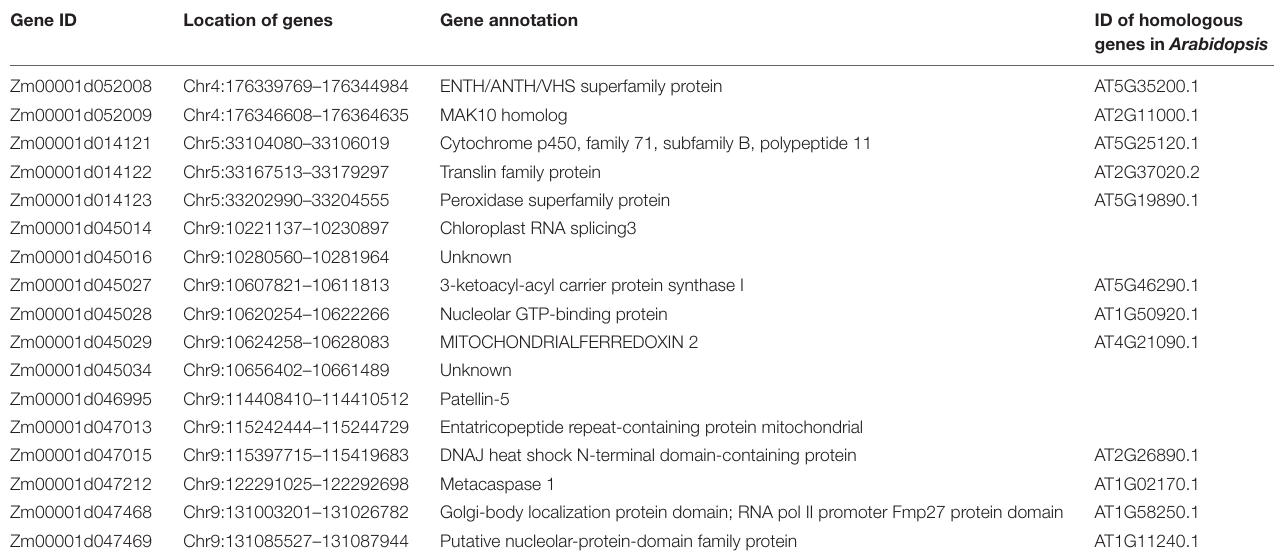
TABLE 3 | Candidate genes for brittleness phenotype based on the SNP-index methods. Gene ID Location of genes Gene annotation ID of homologous